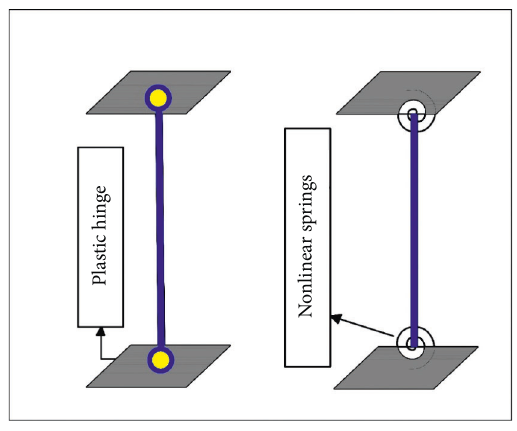
Figure 4: Concentrated plasticity models.